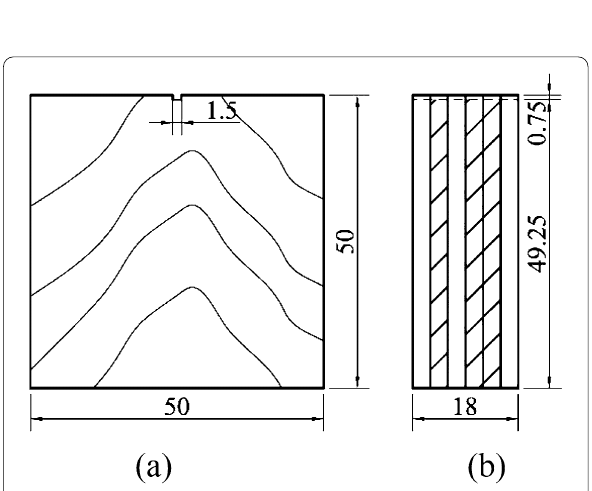
Fig. 3 The general configuration of a half-hole block for evaluating single staple leg-bearing strength in pine plywood a front view, b side view (unit: